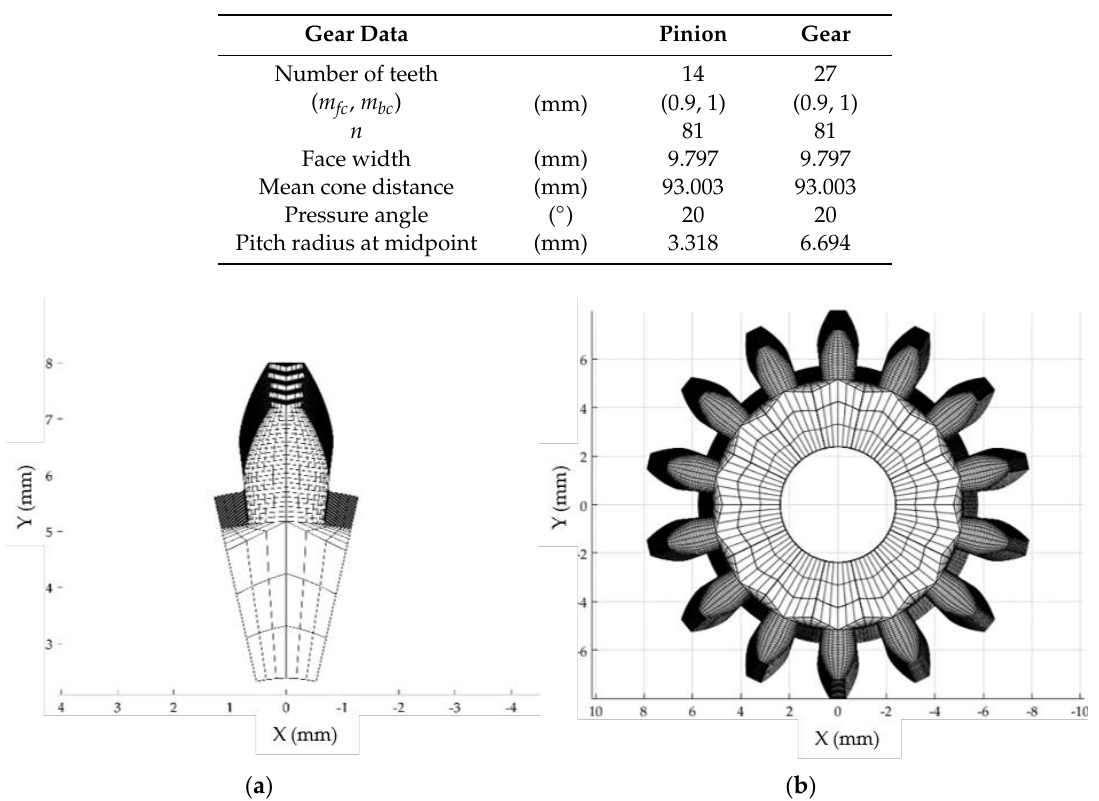
Figure 4. ( a ) Single tooth finite element mesh; ( b ) complete gear finite element mesh.